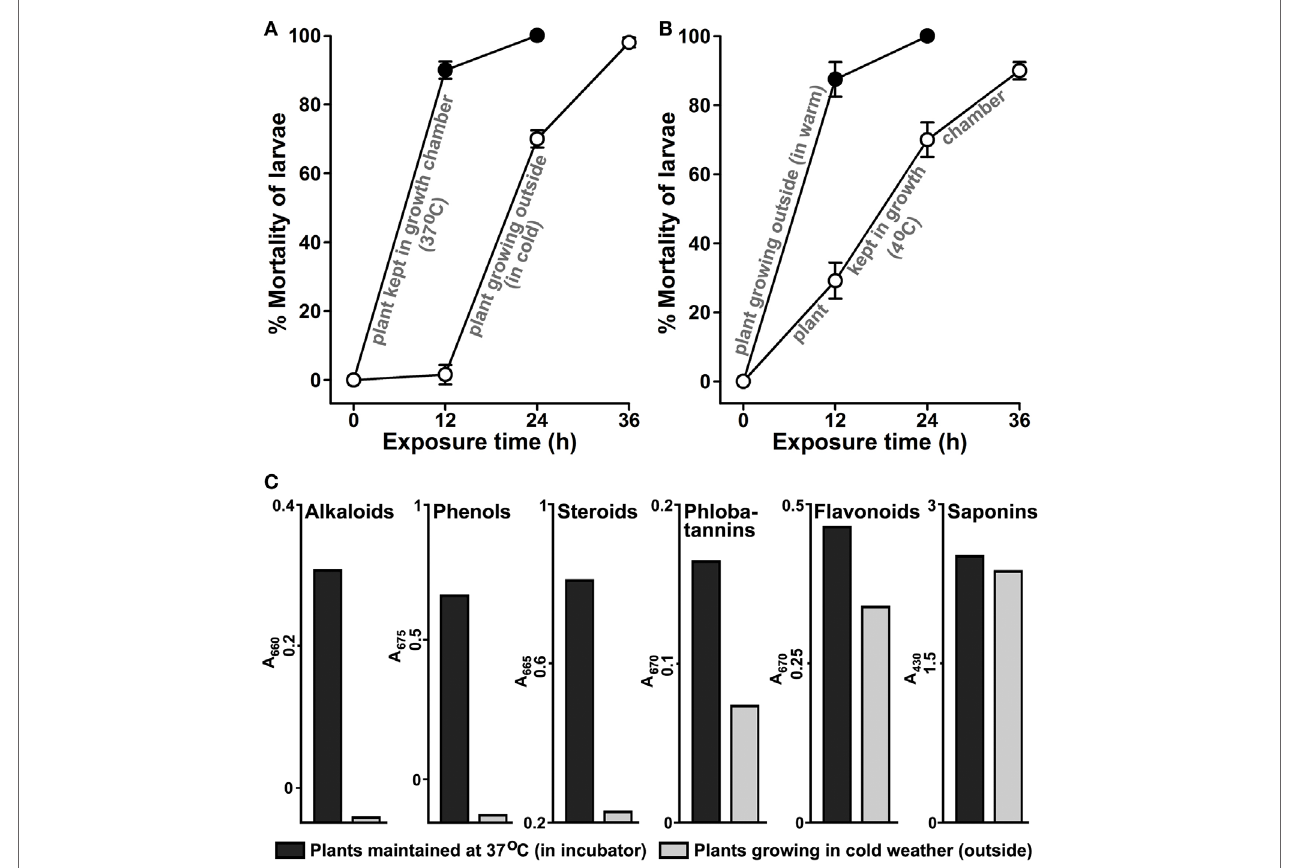
FigUre 7 | Manipulation of environmental temperature induces Agave -mediated larvicidal activity. The effect of environmental temperature on the induction of larvicidal activity in Agave angustifolia was analyzed against A. aegypti larvae. For that, the larvicidal activity in 100 μ g/ml aqueous extract was compared from the plants that were growing or maintained in two different environmental conditions. The comparative larvicidal activities are shown here in those plants that were growing (a) outside in the cold environment during winter season and similar plants maintained at 37°C in a plant growth chamber or (B) outside in hot environment during the summer season and similar plants maintained at 4°C in a growth chamber as discussed in Section “Material and Methods.” The percentage mortality of larvae at each time point was calculated against the sham-treated controls (not shown here) and represented as the mean ± SD of triplicates. (c) The relative levels of various secondary metabolites were compared in the aqueous extracts of Agave angustifolia plants maintained at 37°C in a plant growth chamber or growing in external environment during cold season as mentioned in the panel A. The values represent absorption maxima (a) in visible range for each metabolite